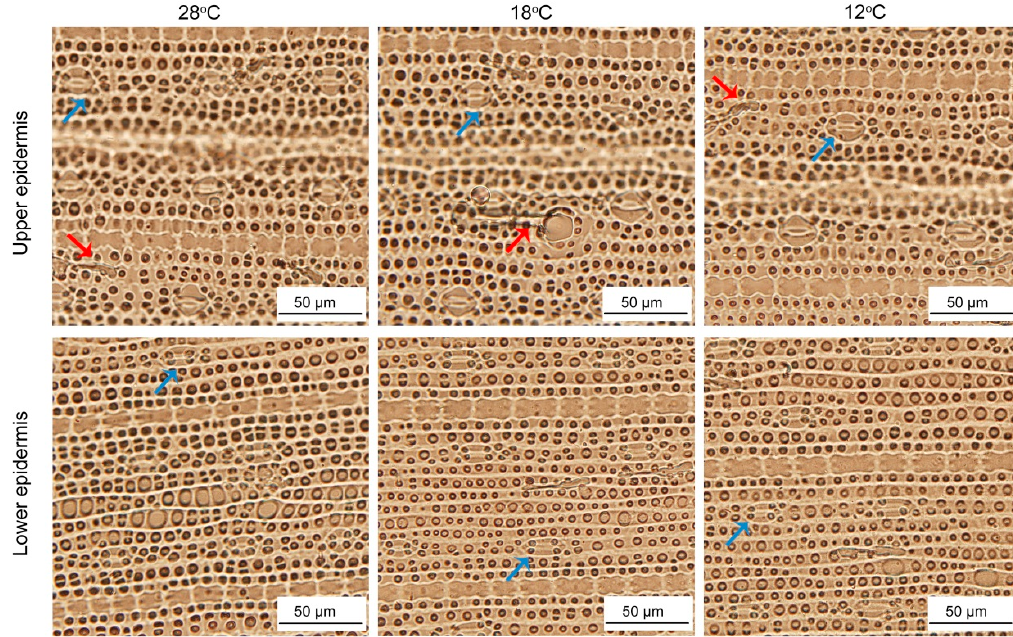
Figure 11. The epidermis cells development of control and chill-stressed rice leaves. Six day old etiolated seedlings were treated with 18 ◦ C or 12 ◦ C chilling stress. Seedlings were harvested at 48 h of greening and their epidermal cells’ characteristics were observed. Red arrows and blue arrows represent trichomes and stoma,